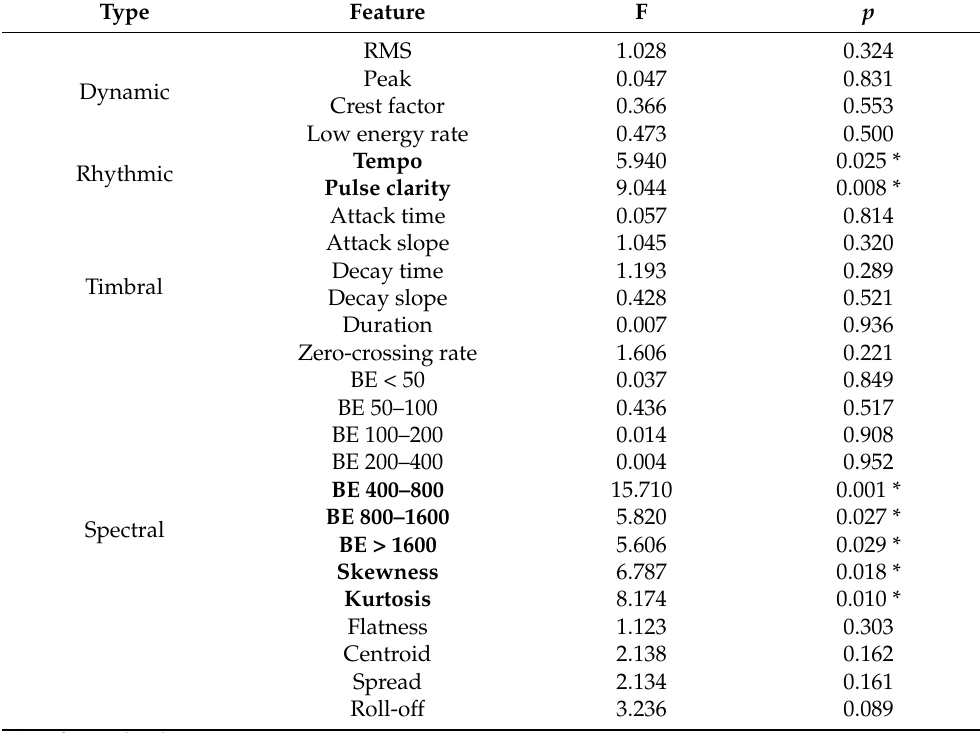
Table 3. The list of extracted features and one-way analysis of variance (ANOVA)